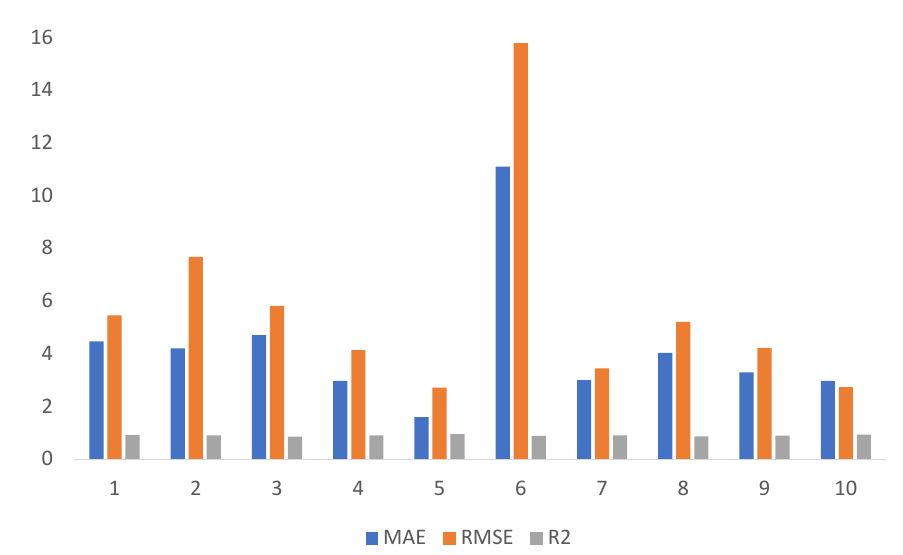
Figure 11. Results of K-fold validation.